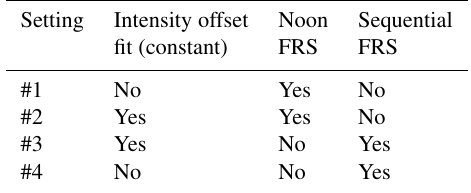
Table 3. Four DOAS fit settings for the synthetic spectra. Setting